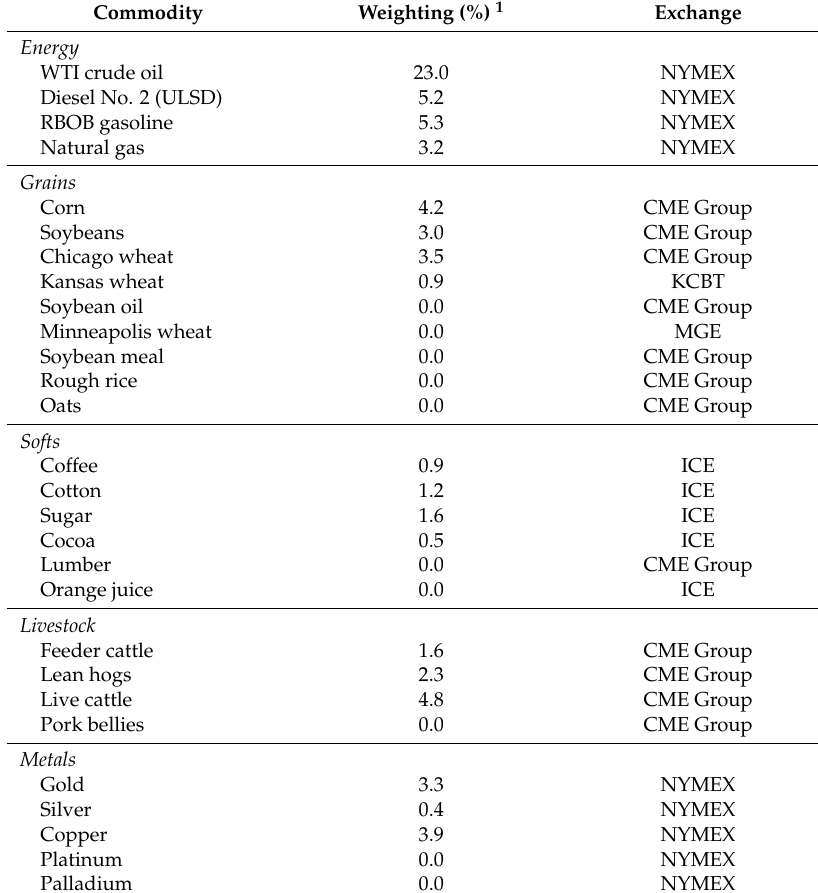
Table 1. Commodity Futures Traded in the United States and Weights in the S&P